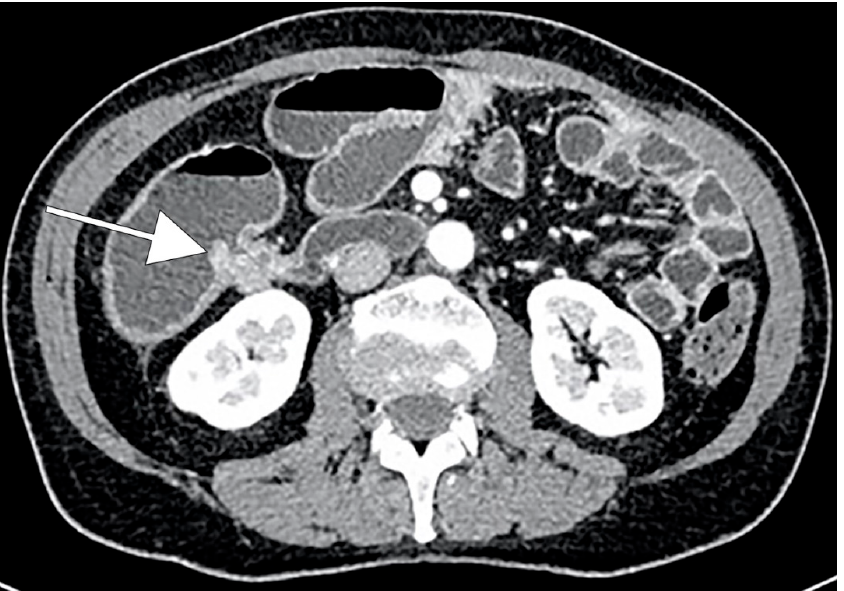
Figure 1. CT scan demonstrating wall thickening colorectal cancer (CRC) of the right colon (white arrow). (white